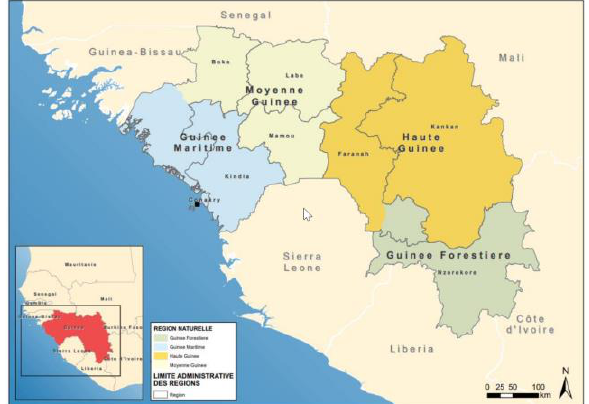
Figure 1. The natural regions of the Republic of